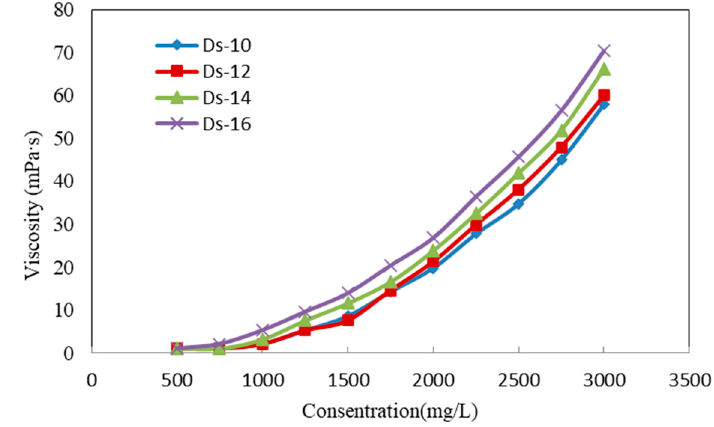
Figure 6. Effects of hydrophobic monomers with different carbon chain lengths on temperature and salinity tolerance of polymers. Carbon chain length: DS16 > DS14 > DS12 > DS10.